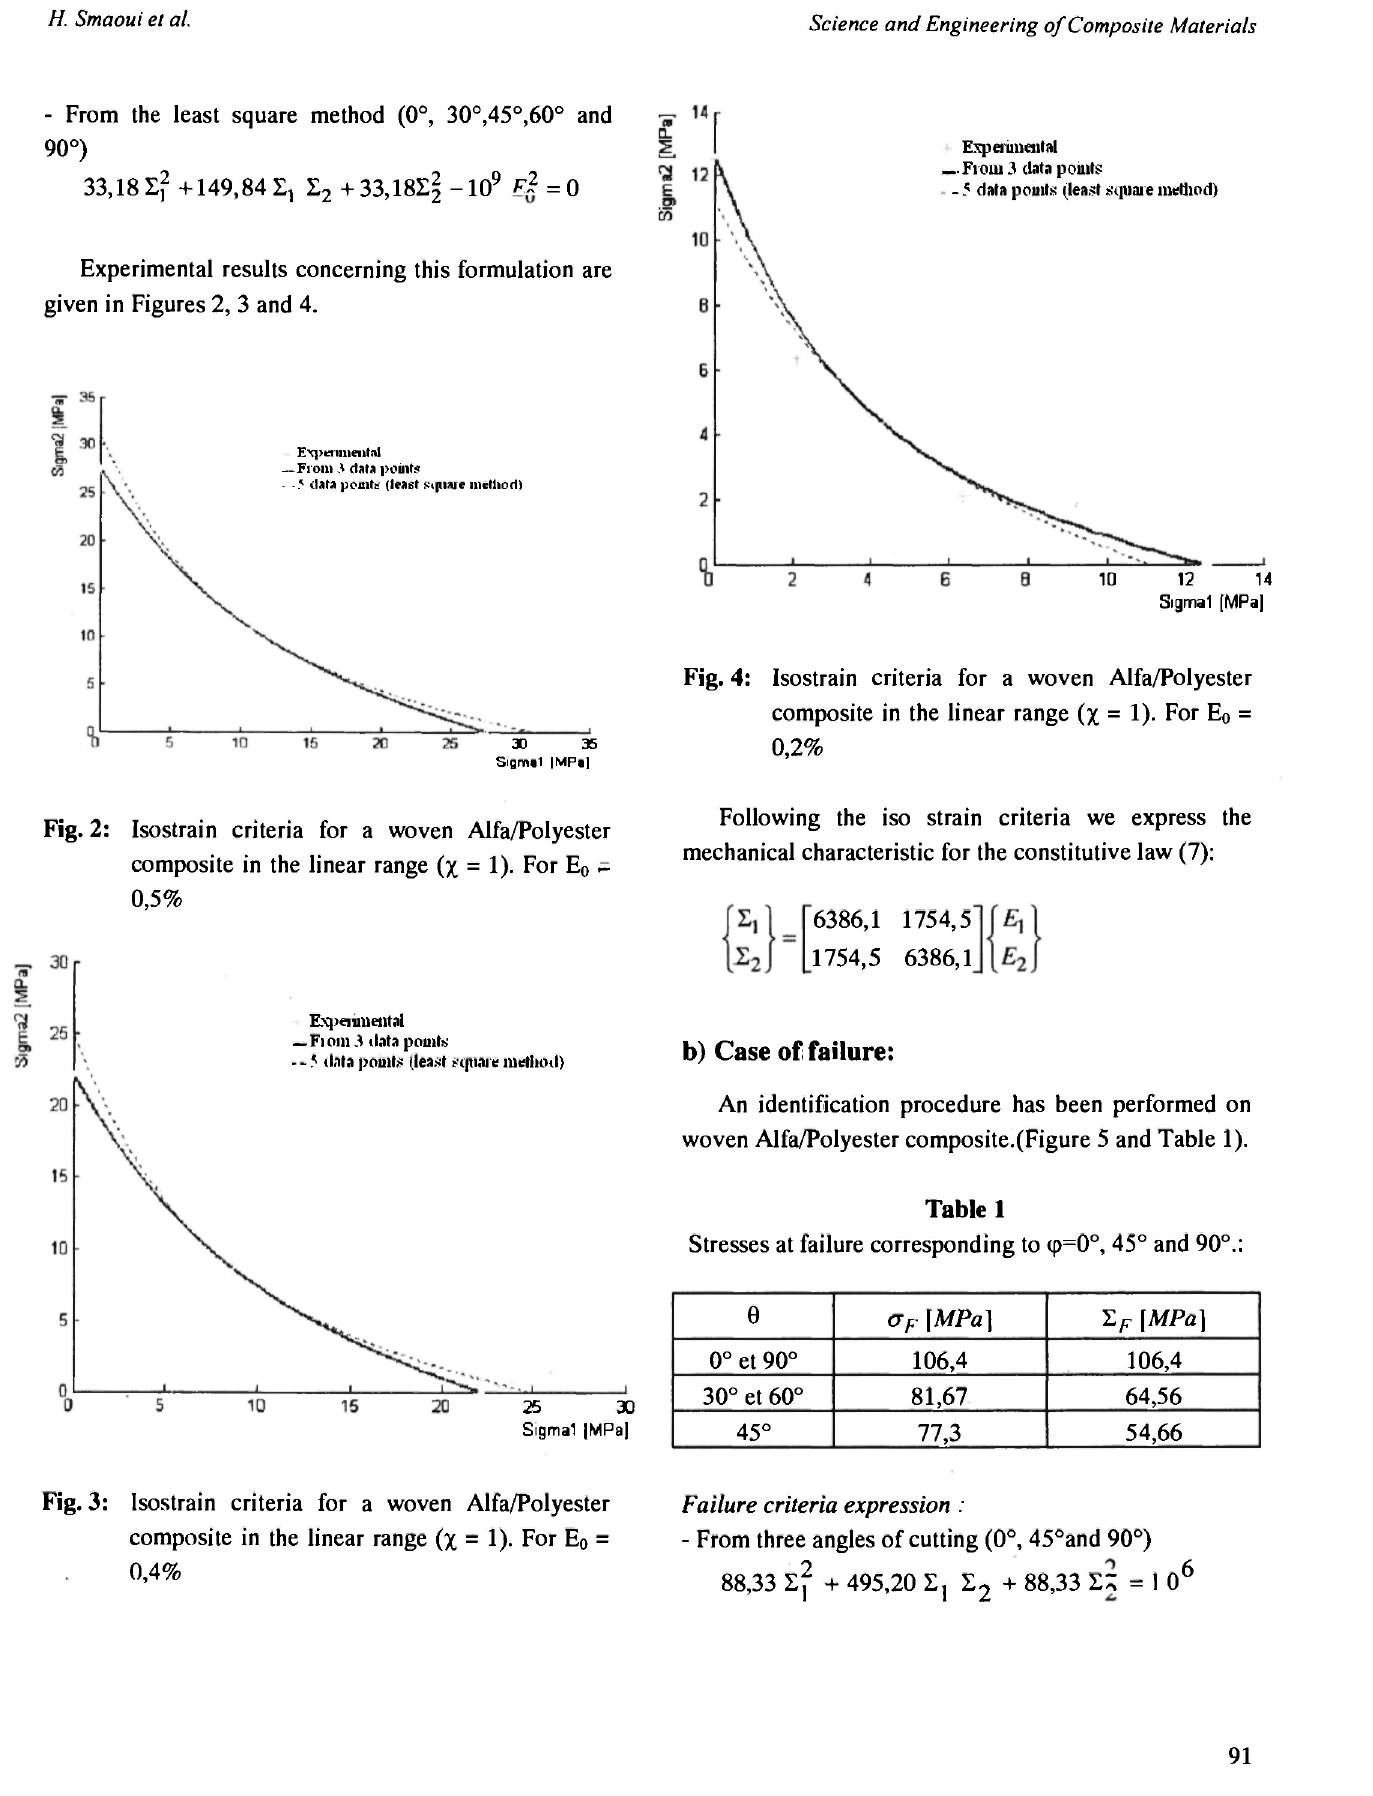
Failure criteria expression : - From three angles of cutting (0°, 45°and